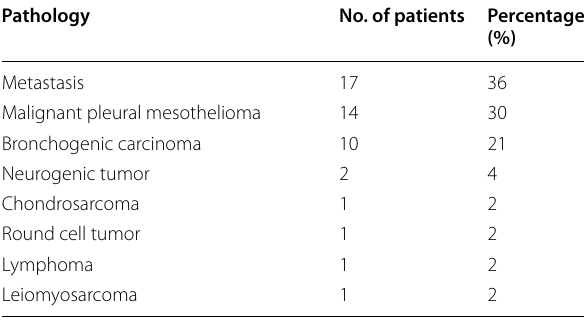
Table 5 Number and percentage of patients with neoplastic conditions leading to soft tissue infiltration of the EPS Pathology